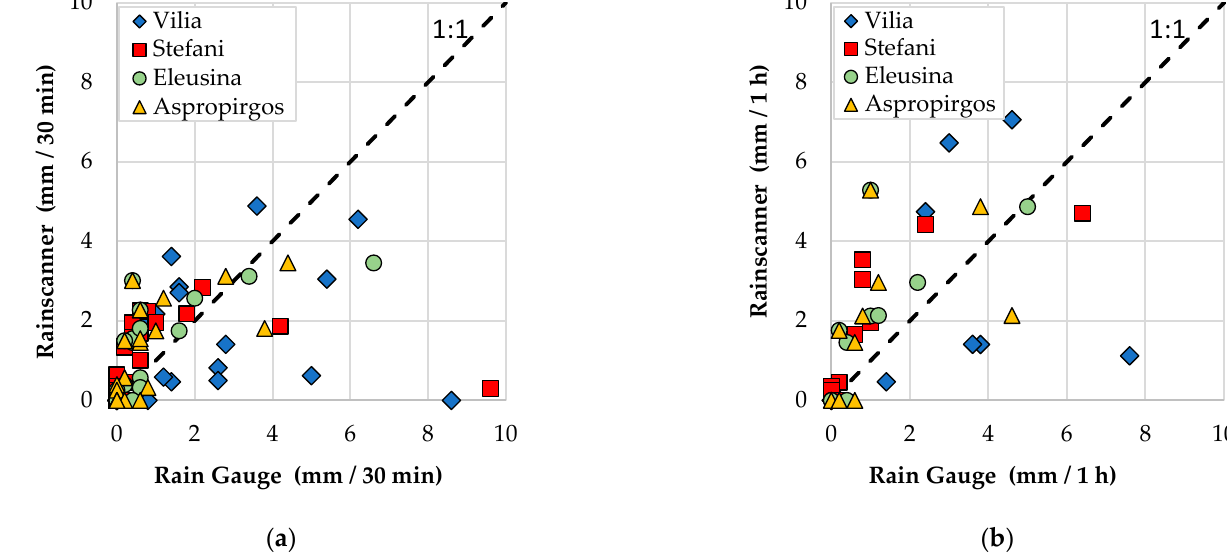
Figure 3. Rainscanner and rain gauge scatter plots, ( a ) on a 30 min temporal scale, and ( b ) on a 1 h temporal scale. Table 1. Correlation coefficient for different time interval scales.